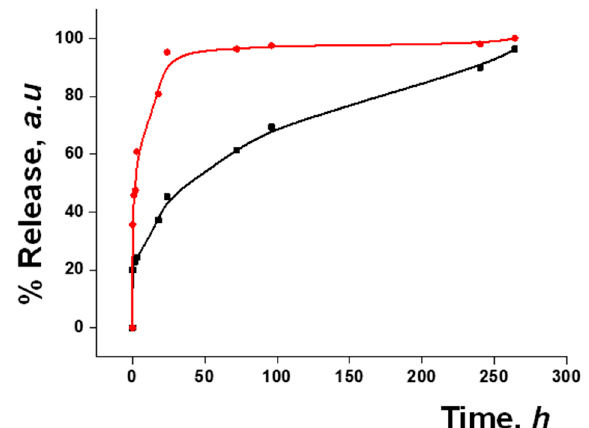
Figure 5. Release profile of MSNs as quantified by NTA from HA-based (black line) and chitosan- β -GP (red line) gels in PBS.